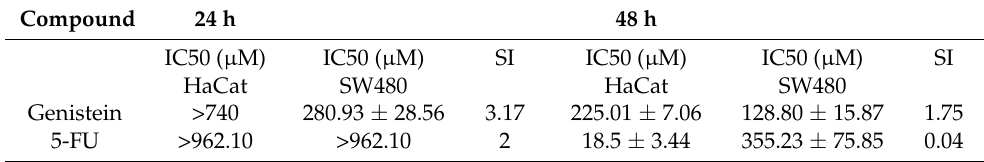
Table 1. Cytotoxic effect of genistein on HaCaT and SW480 cells. Compound